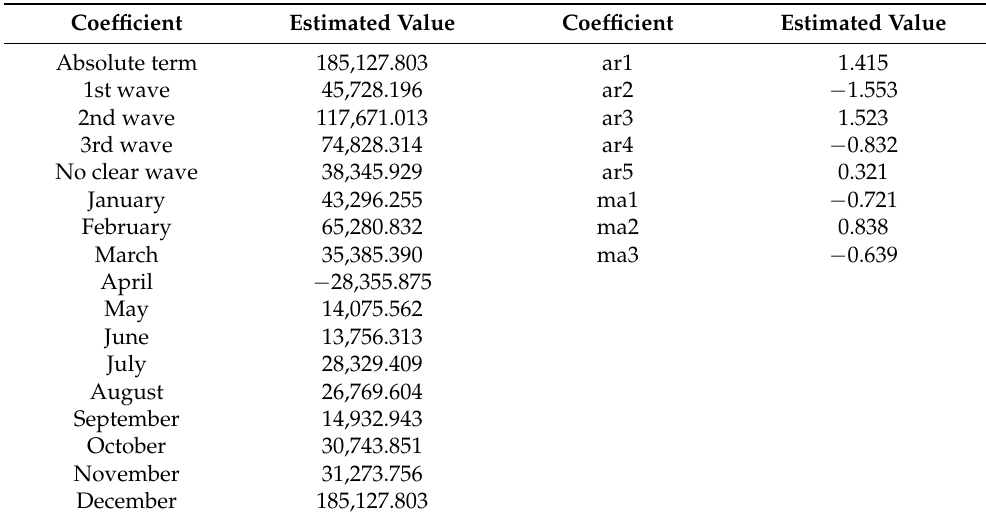
Table 5. ARMAX model